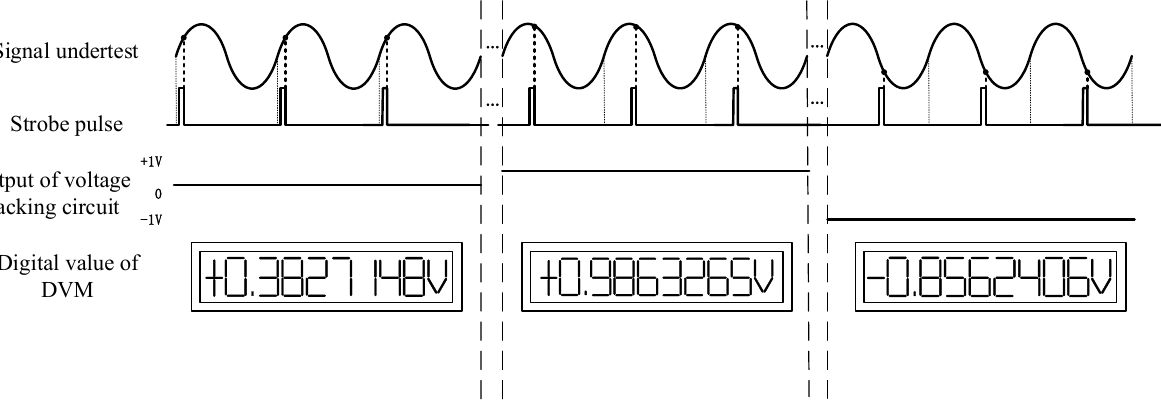
Figure 3. Waveform diagram illustrating the sampling digitization process.